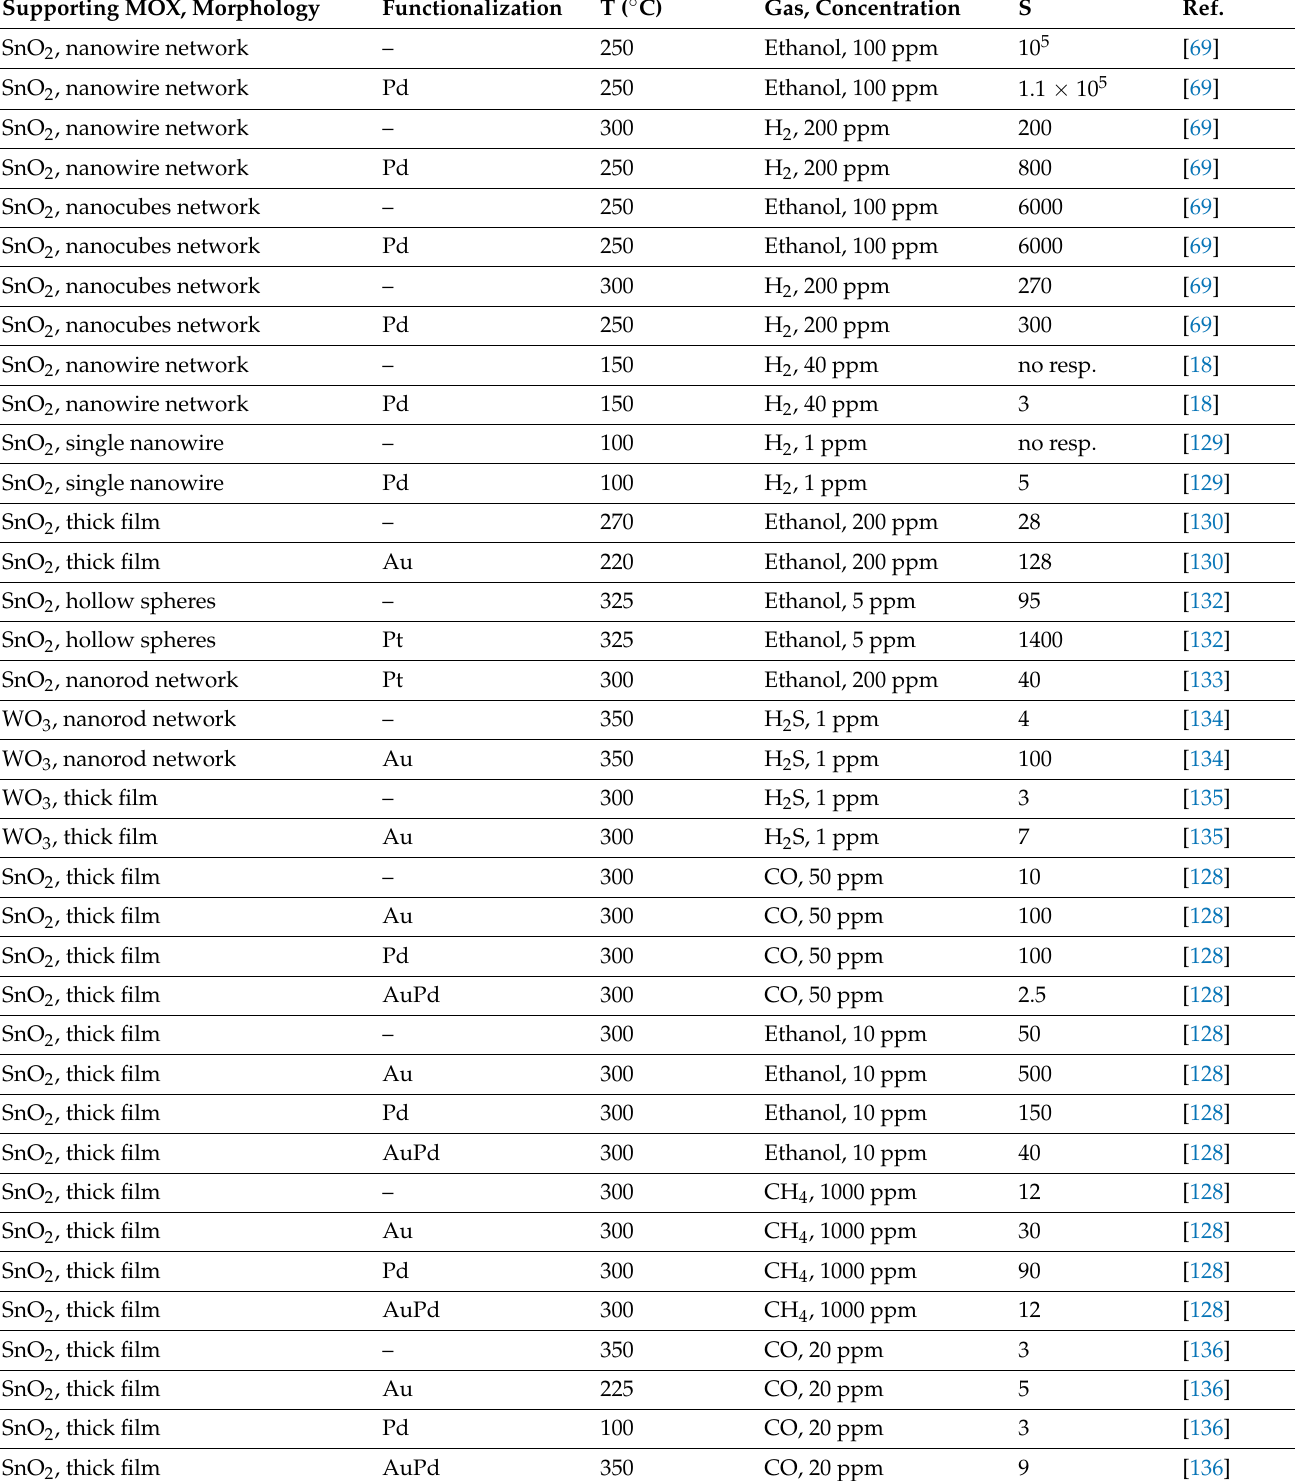
Table 2. Chemiresistors based on metal oxide (MOX) nanostructures functionalized with metallic nanoparticles. The response intensity S is calculated as S = R air /R gas at the sensor temperature T. In case of no response at this temperature, ‘no resp.’ is reported in the S column. Gas concentrations are expressed in parts per million